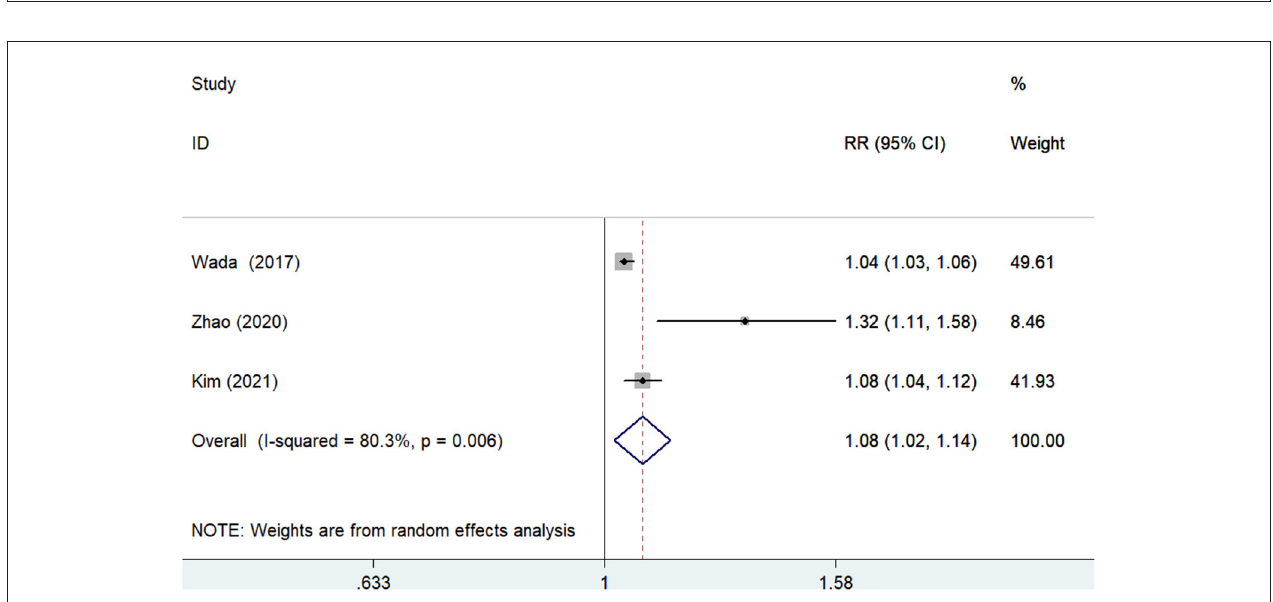
FIGURE 2 | Forest plots showing the pooled RR and 95% CI of all-cause mortality for the lowest vs. the highest GNRI category. RR, risk ratio; CI, confidence interval; GNRI, Geriatric Nutritional Risk Index.